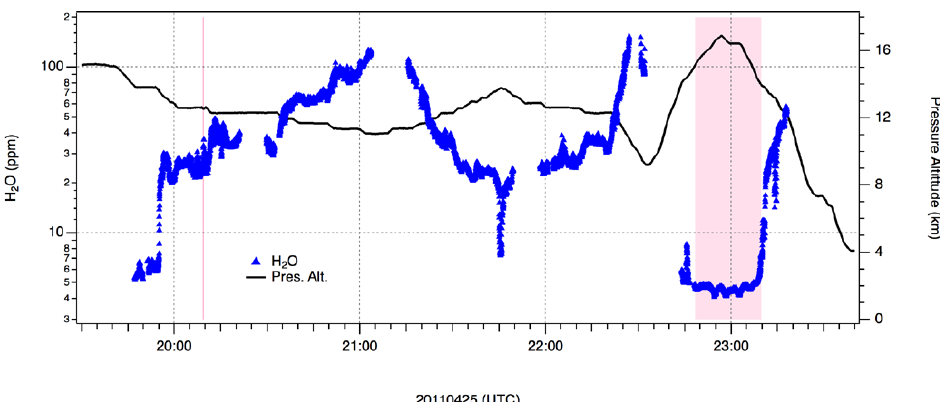
Fig. 11. Time series of H 2 O mixing ratios (blue) measured by the CIMS instrument and aircraft pressure altitude (black) from the MACPEX science flight on 25 April 2011. The highlighted sections correspond to the segments shown in greater detail in Figs. 12 and 13.